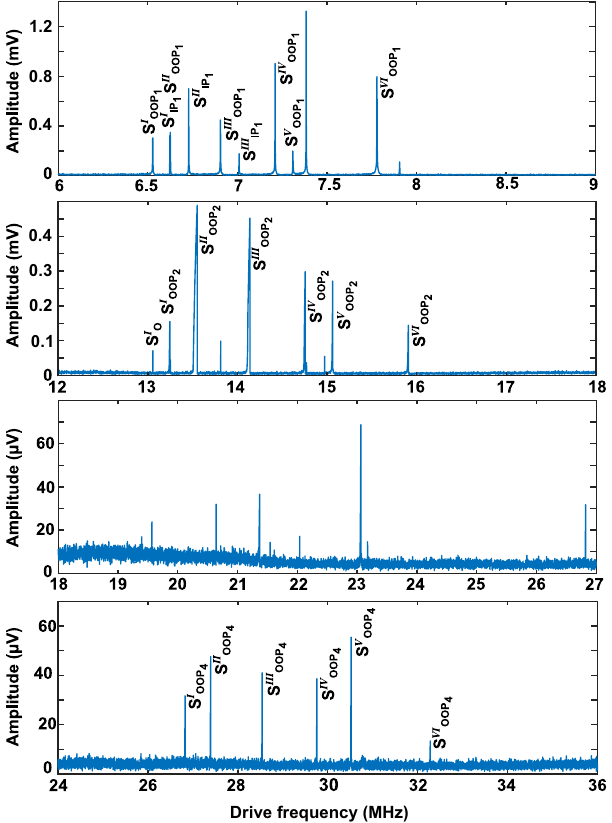
FIG. 6. Mode spectra of the investigated sample hosting six working nanostring resonators. The applied drive powers are − 20 dBm, − 10 dBm, and − 4 dBm, from top to bottom; the lowest two panels are both measured for a drive power of − 4 dBm. The lowest-frequency mode at approximately 6.5 MHz is the OOP mode of the longest string discussed in this work. Identified modes are labeled by the string number (S I to S VI , from the longest to the shortest working nanostring), the mode polarization (OOP or IP for out-of-plane and in-plane modes), and the harmonic (1 to 4 from refers to the fundamental up to the fourth harmonic). The label S I O the second overtone at exactly twice the eigenfrequency of the OOP mode at 6.5 MHz. It does not correspond to an eigenmode of the system. The spurious mode at 19.56 MHz in the third panel remains unlabeled. Other modes in this panel are third harmonics, which, however, could not be unambiguously assigned to the eigenmodes of the six-string system.